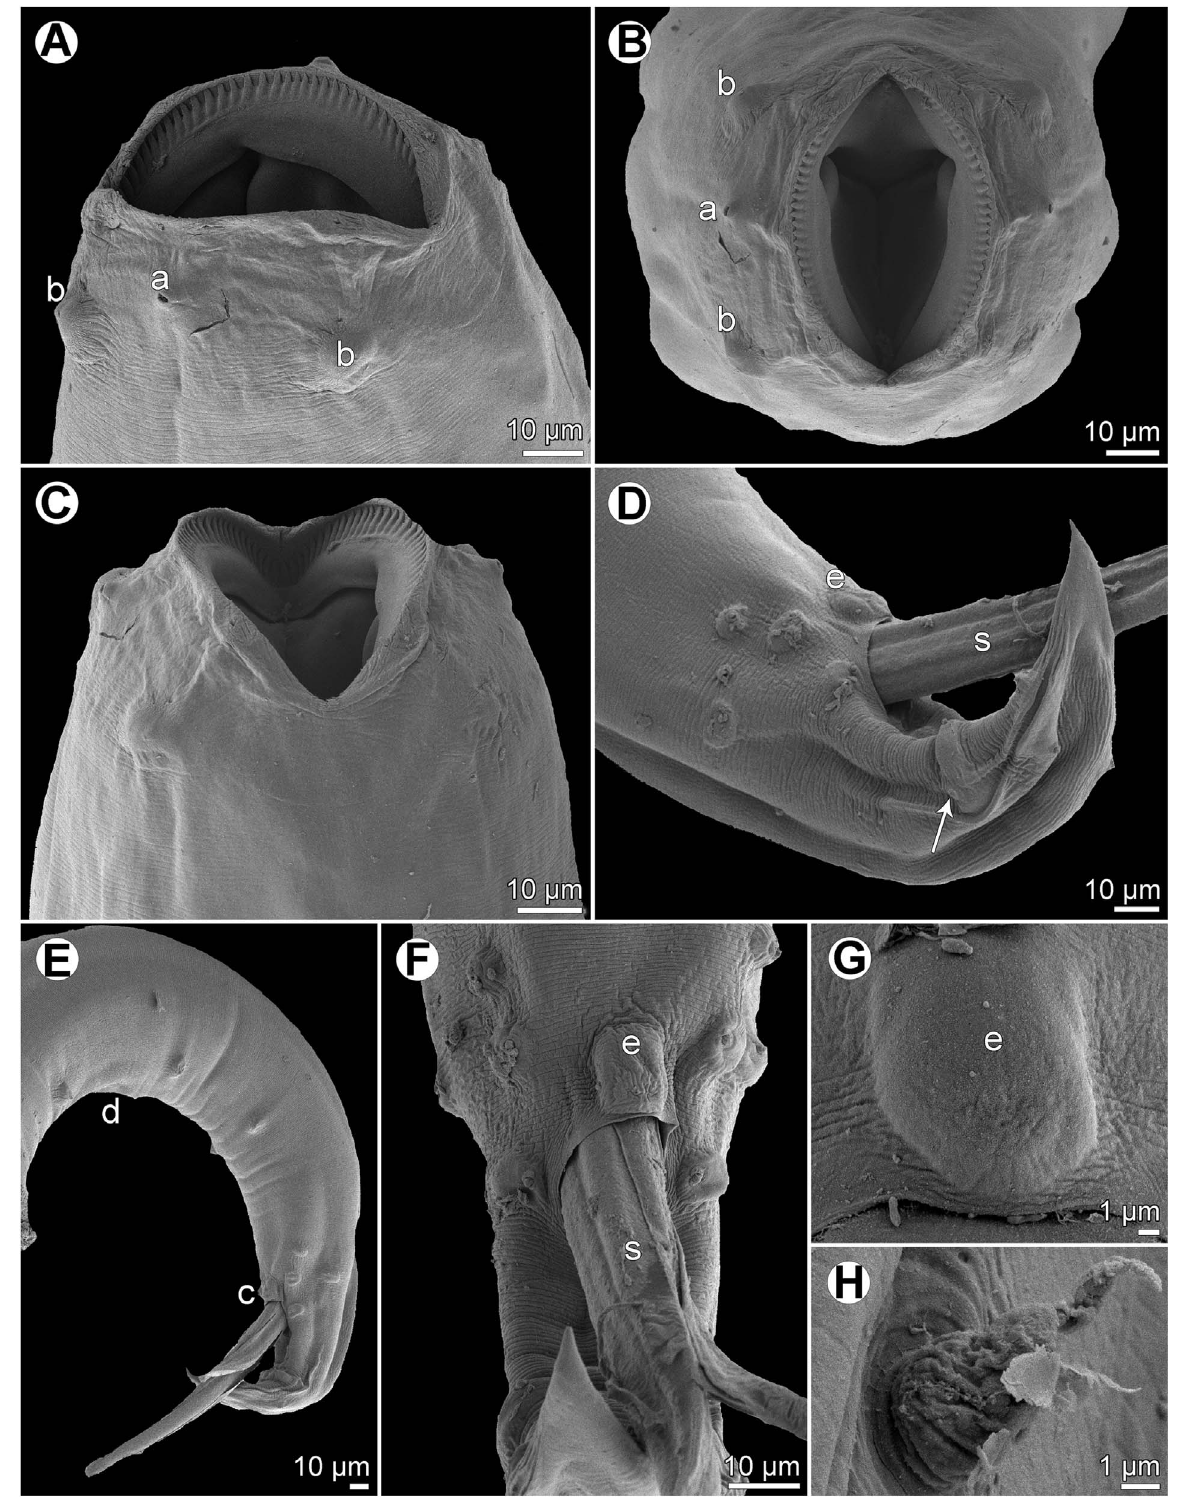
Figure 5. Cucullanus acutospiculatus n. sp. from Caesio cuning , scanning electron micrographs of male. (A) – (C) Cephalic end, lateral, apical and dorsoventral views, respectively; (D) tail, lateral view (arrow indicates phasmid); (E) posterior end of body, lateral view; (F) cloacal region, ventral view; (G) median precloacal elevation, ventral view; (H) deirid. (a) Amphid; (b) cephalic papilla; (c) cloaca; (d) ventral sucker; (e) median precloacal elevation; (s)